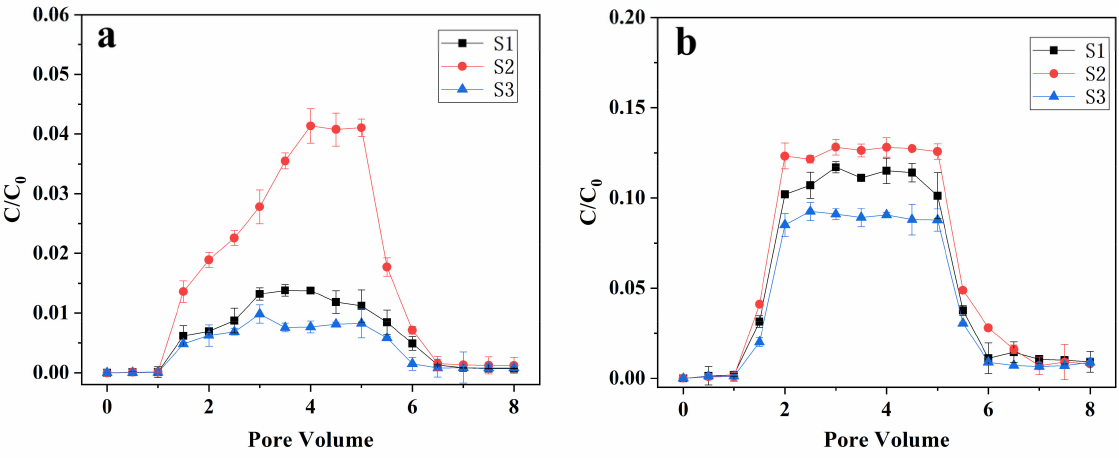
Figure 5. Breakthrough curves of nZVI ( a ) and B-nZVI ( b ) through columns packed with different soils. Error bars represent standard deviations of triplicate